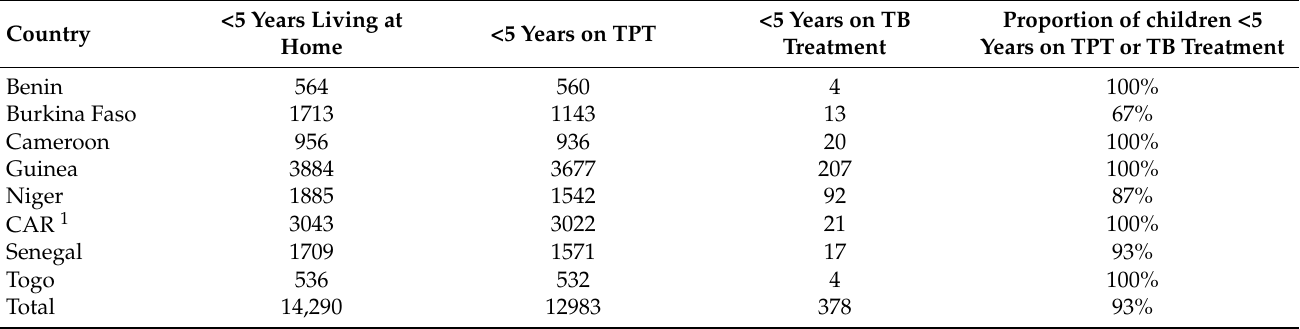
Table 2. Proportion of children under 5 years living at home and on preventive treatment or TB